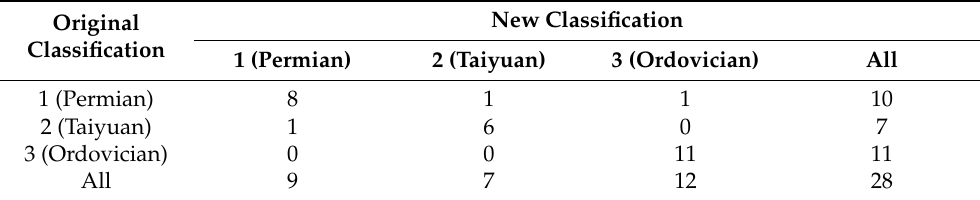
Table 9. Retrospective discrimination results of Bayes multi-class LDA function for trace